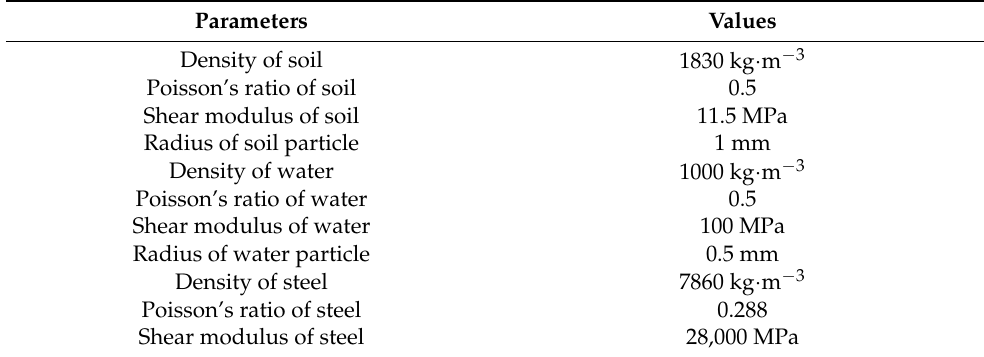
Table 2. Material parameter table.